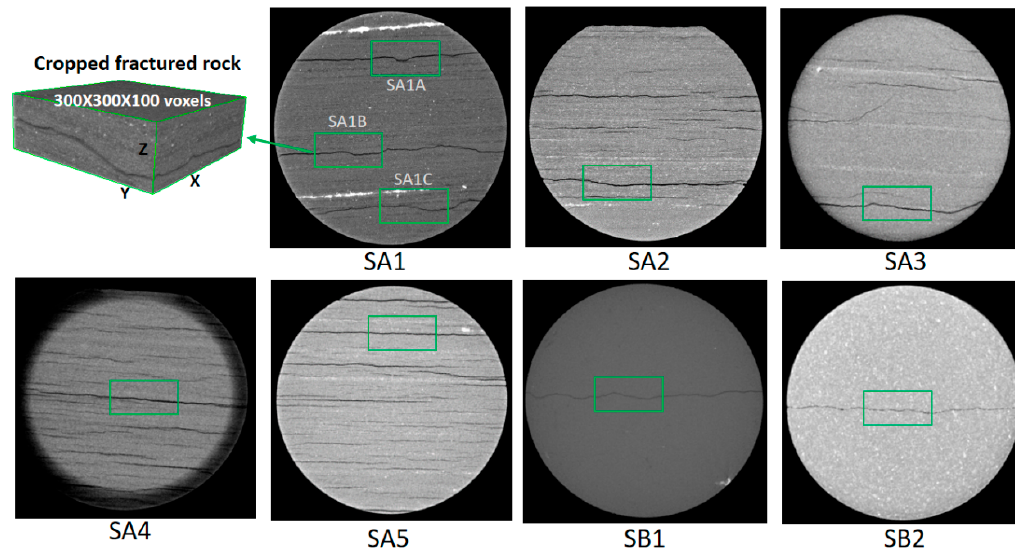
Figure 15. Seven slice images of CT images of 1024 3 voxels scanned on 5 shale and 2 sandstone cores, a sub-image that contains a single fracture is cropped out from each CT image, having a smaller dimension of 300 × 300 × 100 voxels. Table 1. The characteristic parameters of eight different fracture samples presented in the green box of Figure 15 and the sample permeabilities calculated from LBM, cubic law and modified cubic law. Samples